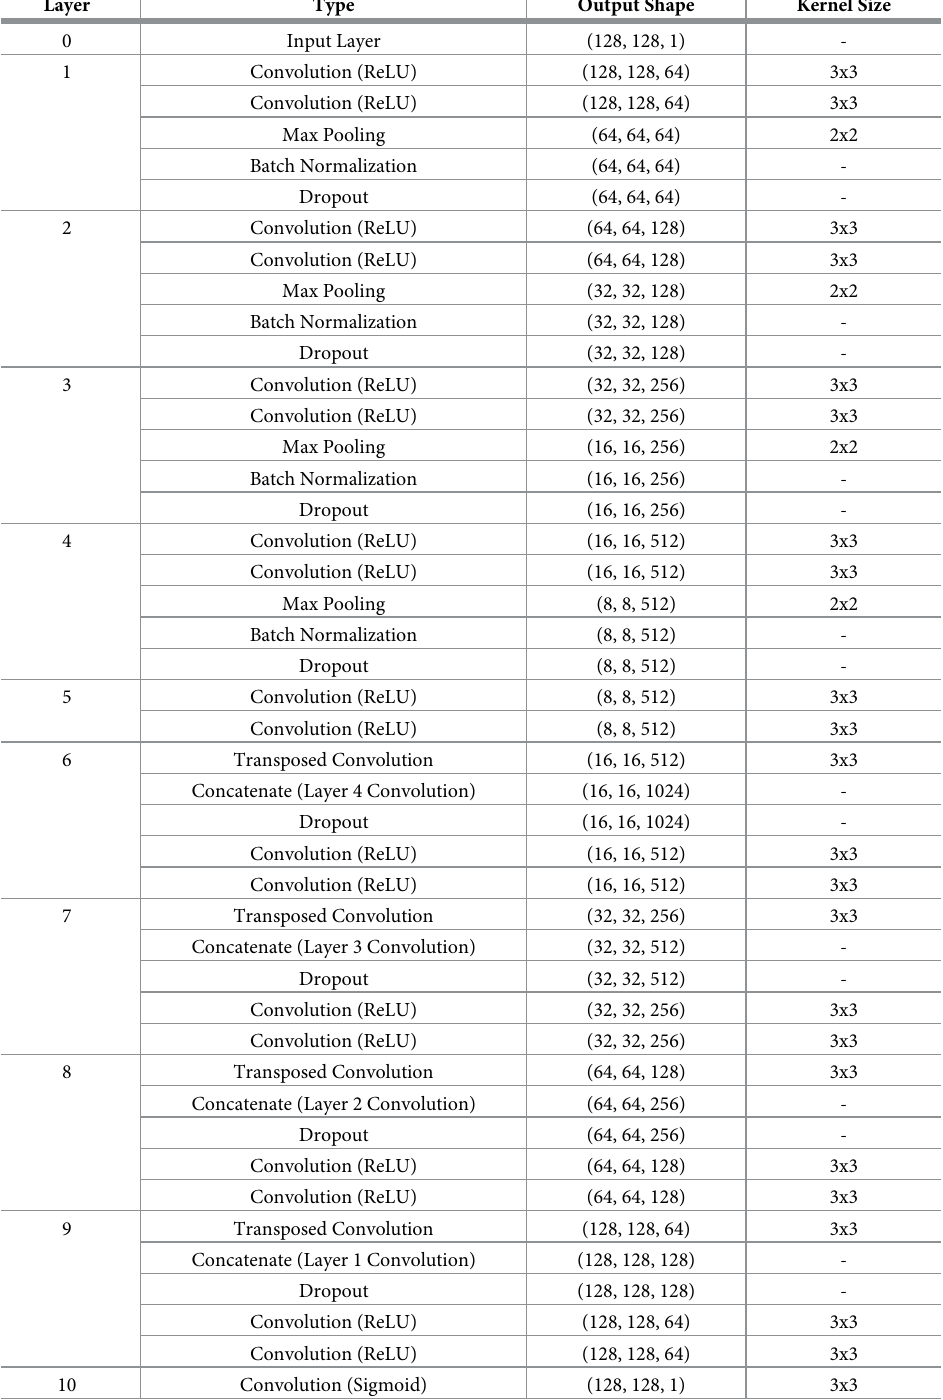
Table 4. 2D U-Net model structure for tumor